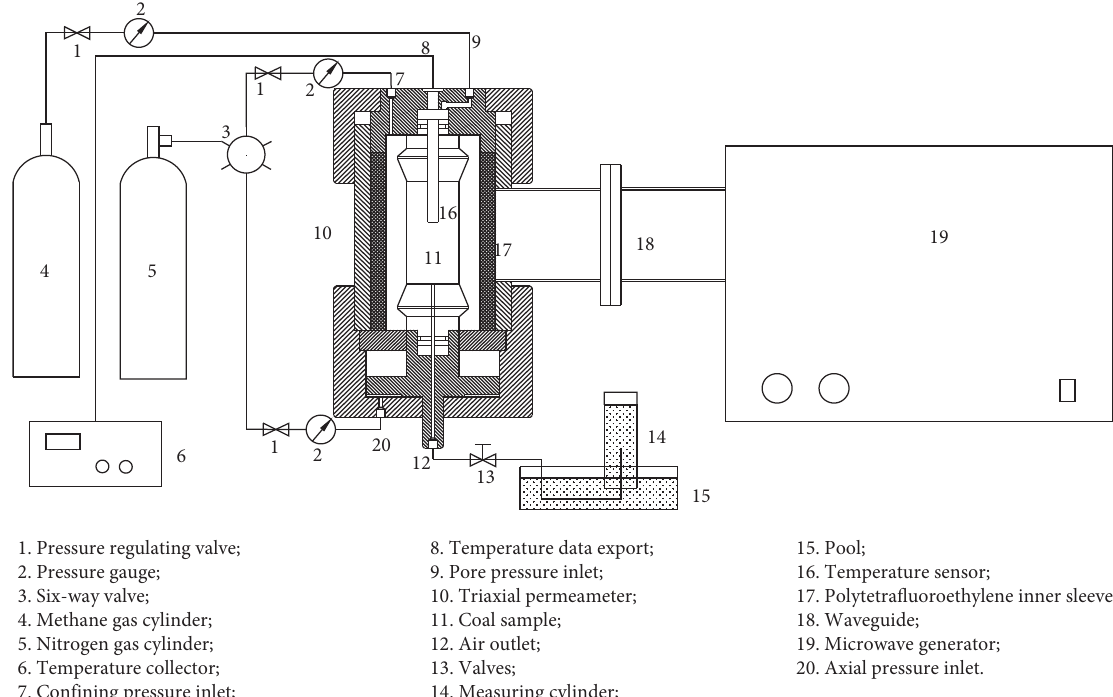
Figure 1: Schematic diagram of the experimental system.